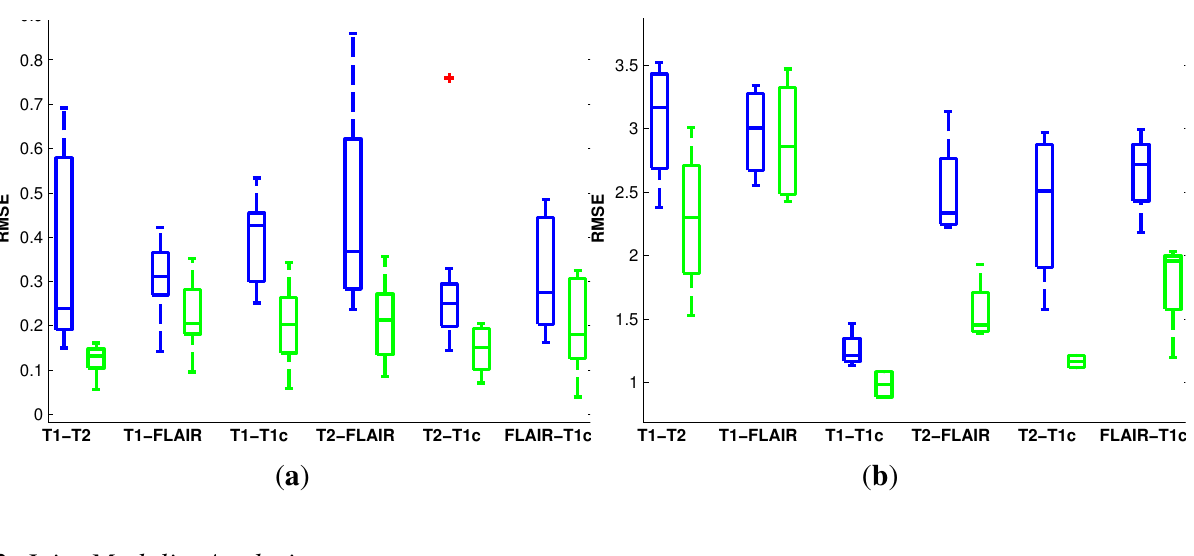
Figure 6. Boxplots of the root mean squared registration errors (in mm) for the BRATS data sets. For each pair of modalities, left-most (blue) boxplots correspond to using MI, while right-most (green) ones correspond to diffusion distance. Red crosses indicate outliers. ( a ) Rigid registration; ( b ) non-rigid registration.